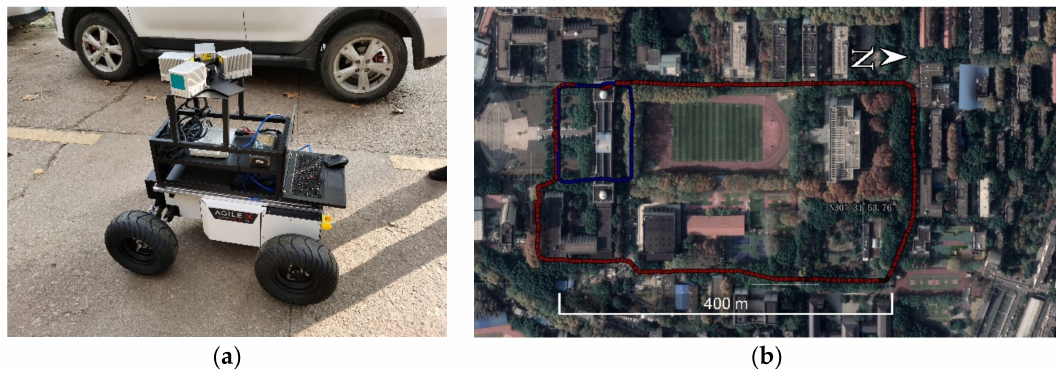
Figure 12. Small platform setup: ( a ) platform overview; ( b ) illustration of the two loops. (blue and red